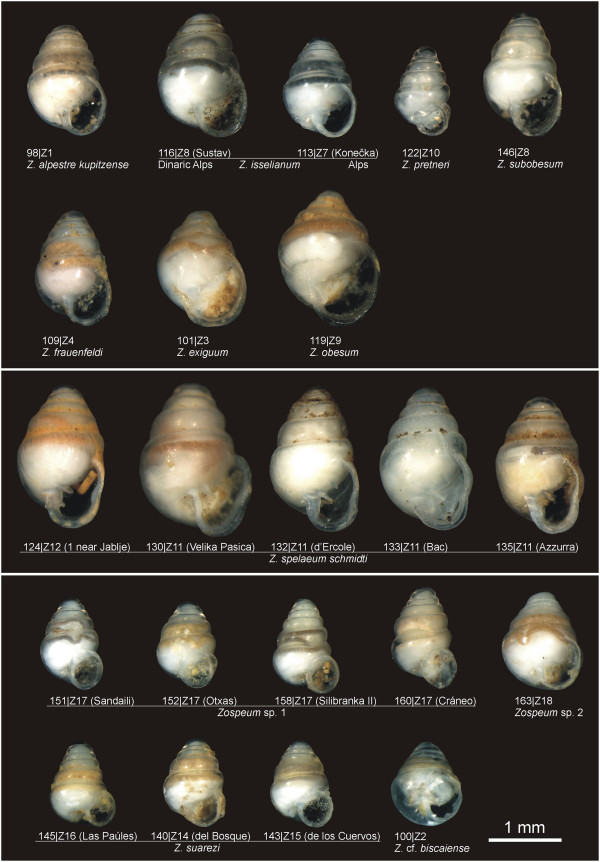
Zospeum morphospecies and corresponding genetic lineages. Traditionally identified morphospecies and their respective delimitated evolutionary lineage (Z1-Z18) and specimen identifier are visualized. In some cases the cave name is provided in brackets.